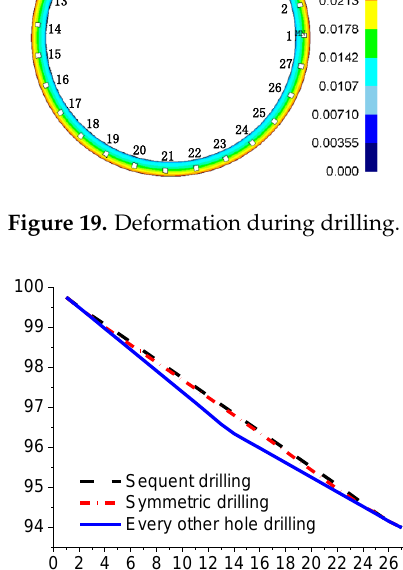
Figure 20. Variation in strain energy with amount of drilling. Table 4. Variations in deformation and strain energy with different drilling